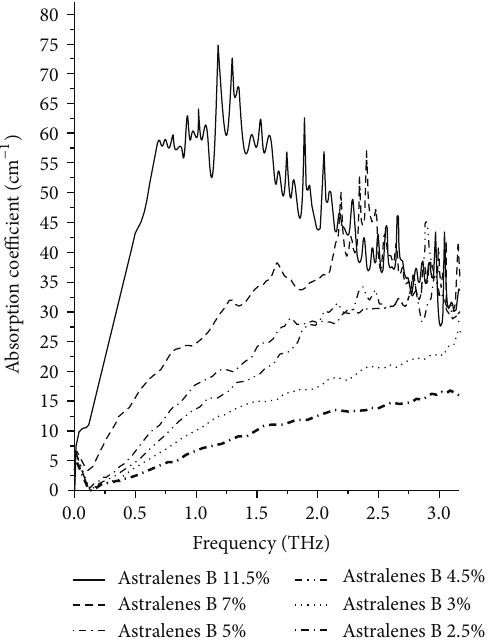
Figure 3: Astralenes absorption spectra changes with the increasing of their concentration in a plastic bag, % mass.